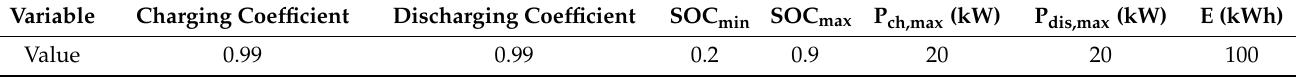
Table 1. Parameter settings of BS.